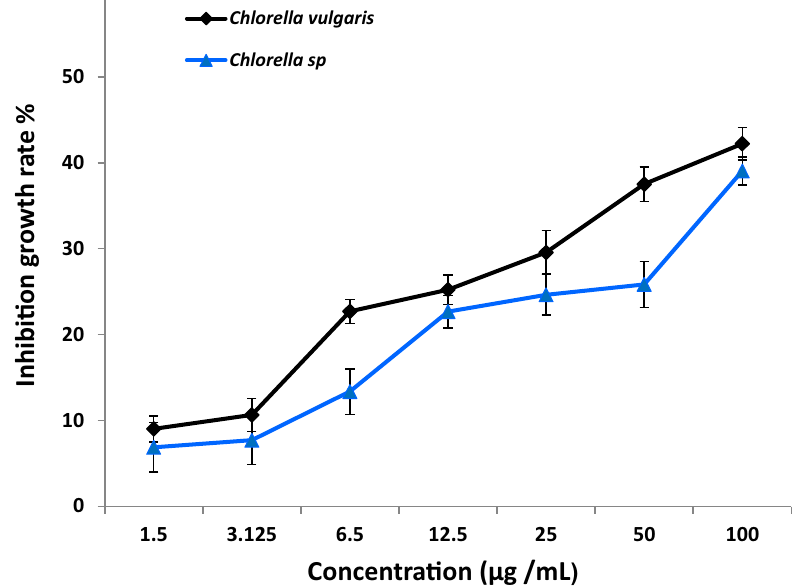
Figure 9. The percent inhibition of growth rate (average specific growth rate %) of Chlorella vulgaris and Chlorella sp after 96 h exposure to different concentrations of OG- AgNPs (100, 50, 25, 12.5, 6.5, 3.125, 1.5 and 0 μg/mL). Data taken from the mean of three replicates, and error bars signify the SD of these